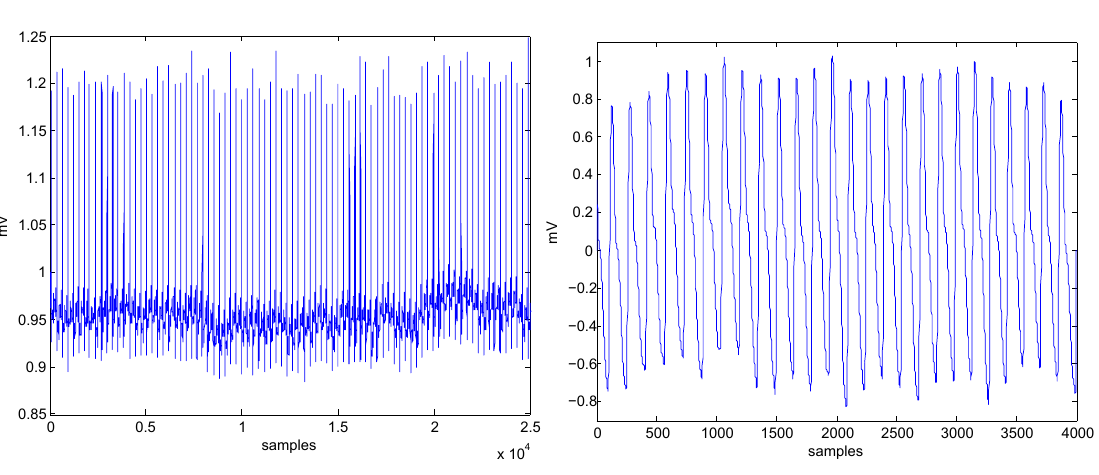
Figure 1. Data used in the analysis ECG signal ( left ) and PPG signal ( right ). Note, ECG stands for electrocardiogram while PPG stands for